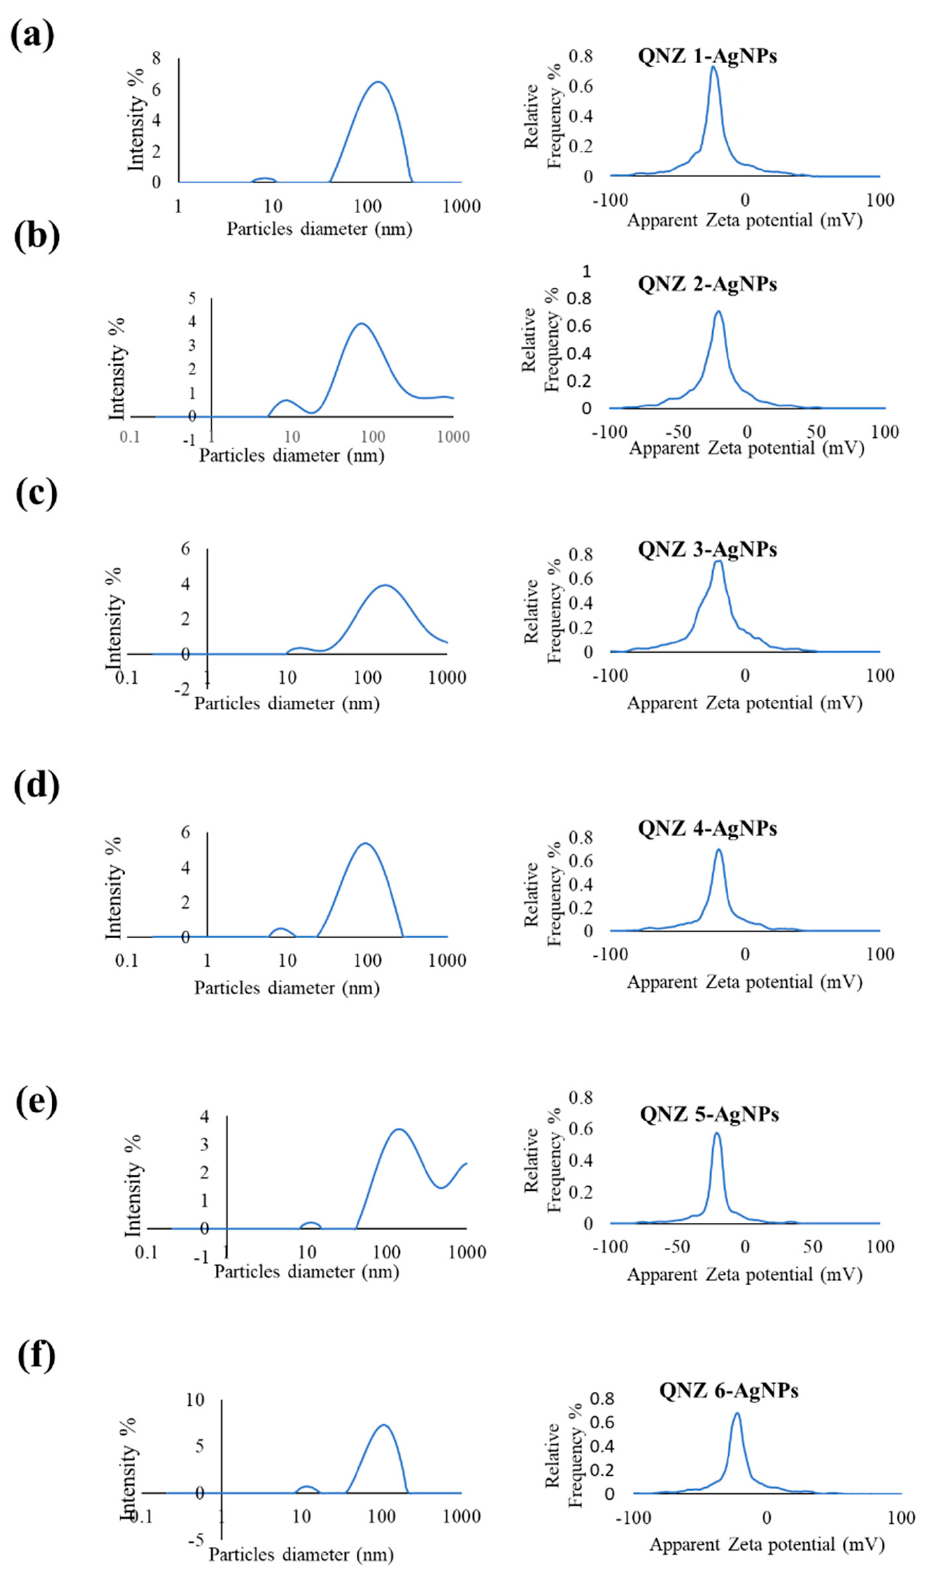
Figure 2. Size distribution histogram and zeta potential plots of QNZ 1-AgNPs ( a ). QNZ 2-AgNPs ( b ). QNZ 3-AgNPs ( c ). QNZ 4-AgNPs ( d ). QNZ 5-AgNPs ( e ). QNZ 6-AgNPs ( f ). which were obtained